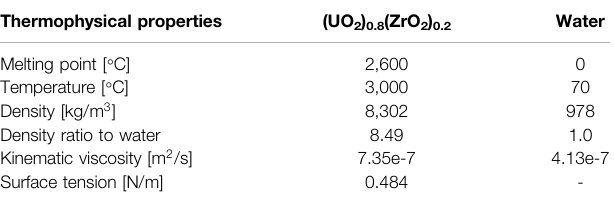
TABLE 2 | Thermophysical properties of the corium.